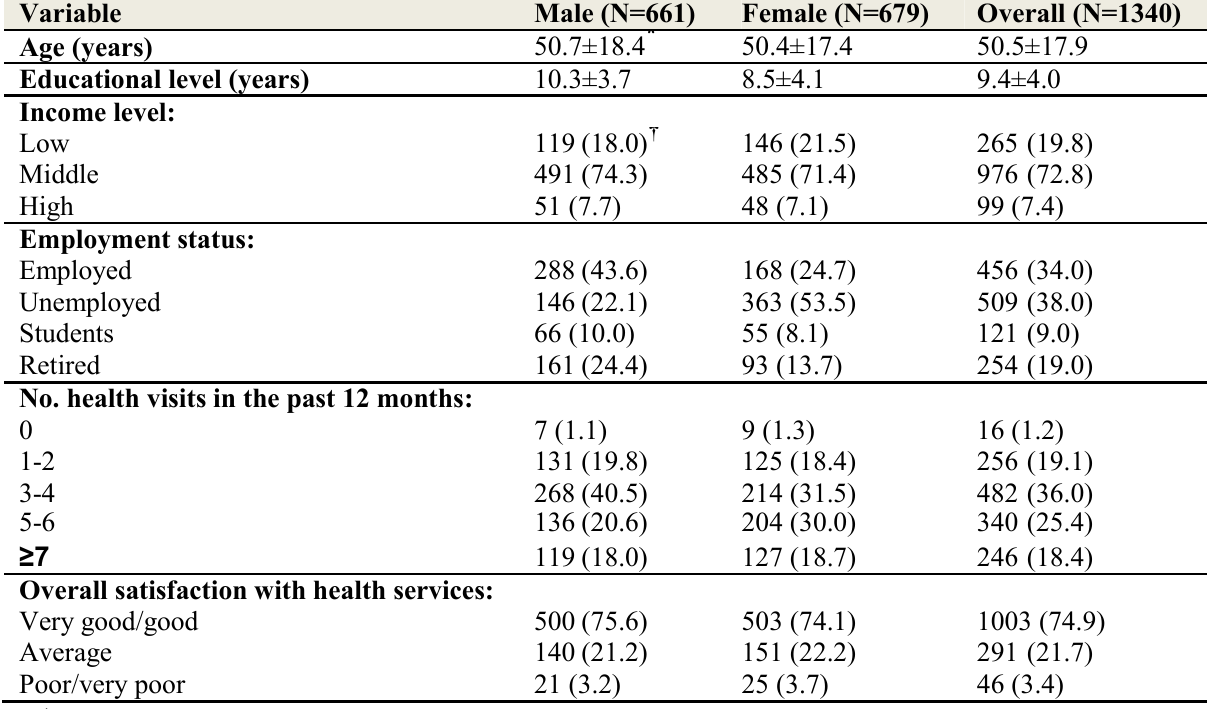
Table 1. Distribution of socioeconomic characteristics and satisfaction with health